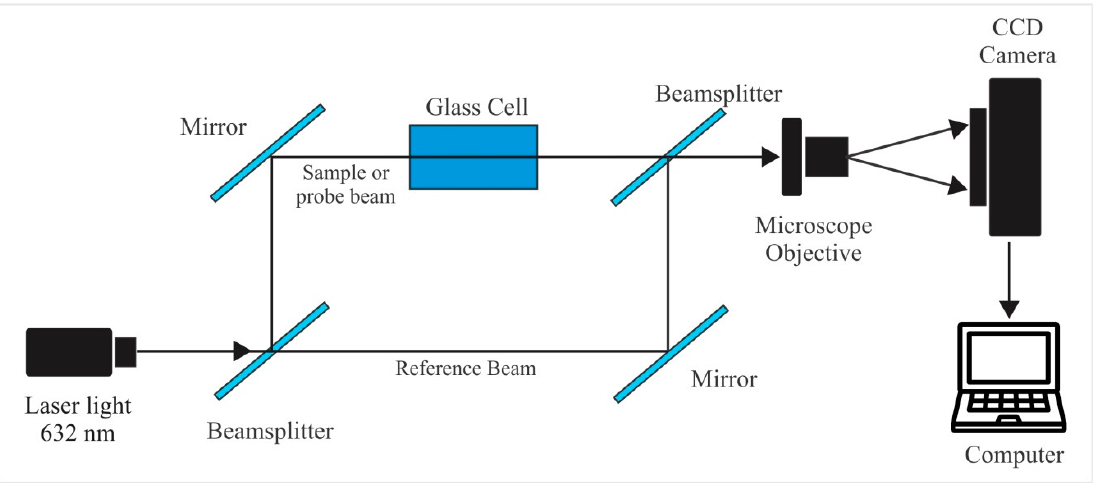
Figure 1. Mach–Zehnder interferometer.